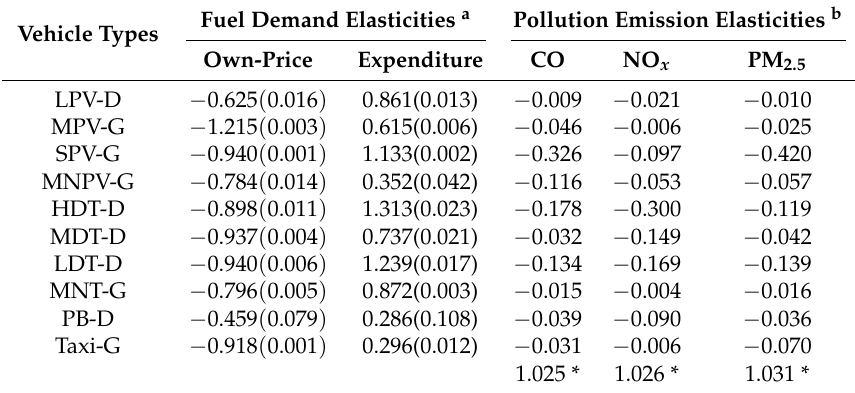
Table 4. Elasticities of fuel demand and air pollution emissions from the AIDS